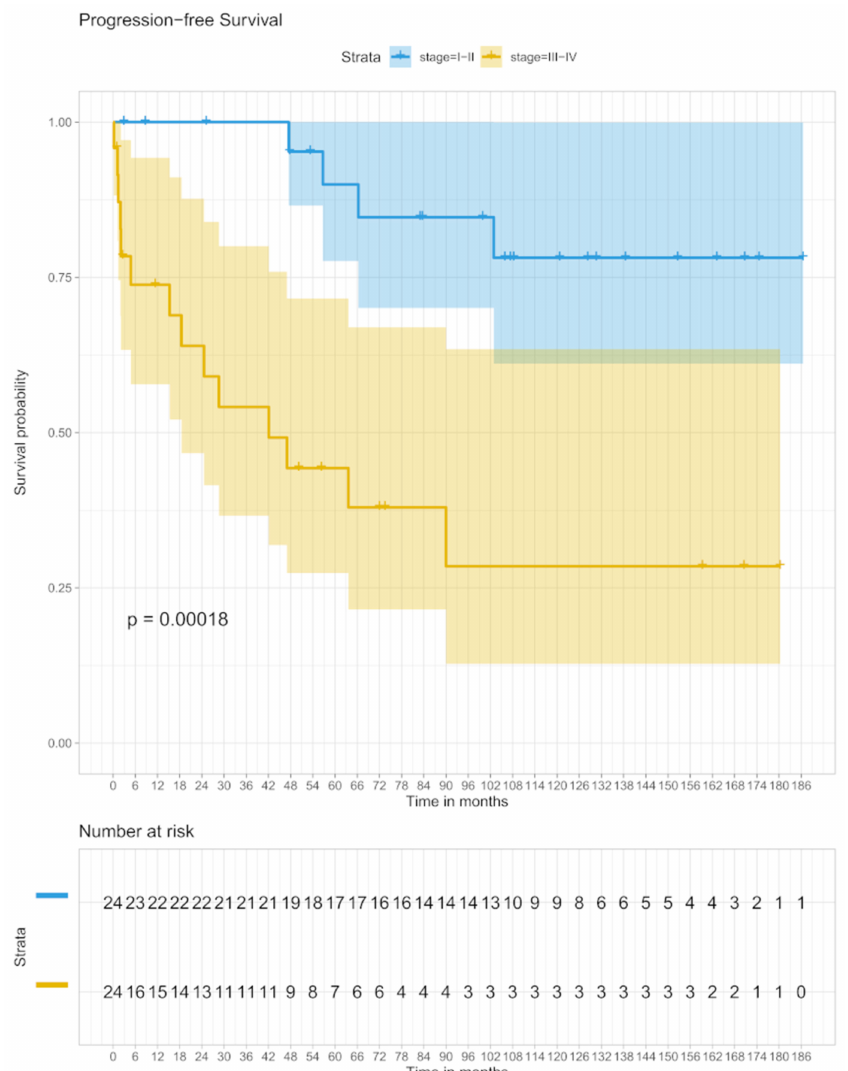
Figure 2. PFS in stage I/II and stage